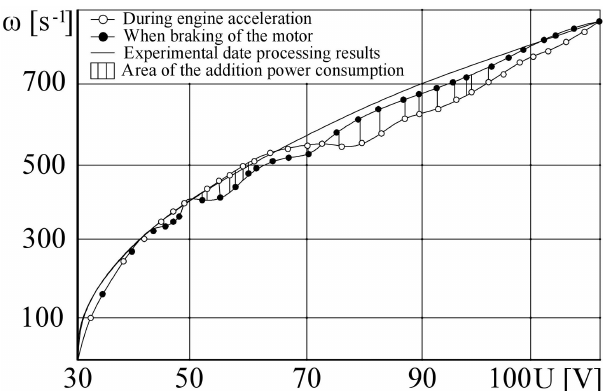
Figure 25. Dependence of the shaft velocity on the tension applied to the engine in case of the fluoroplastic material of the rotor sup- port.